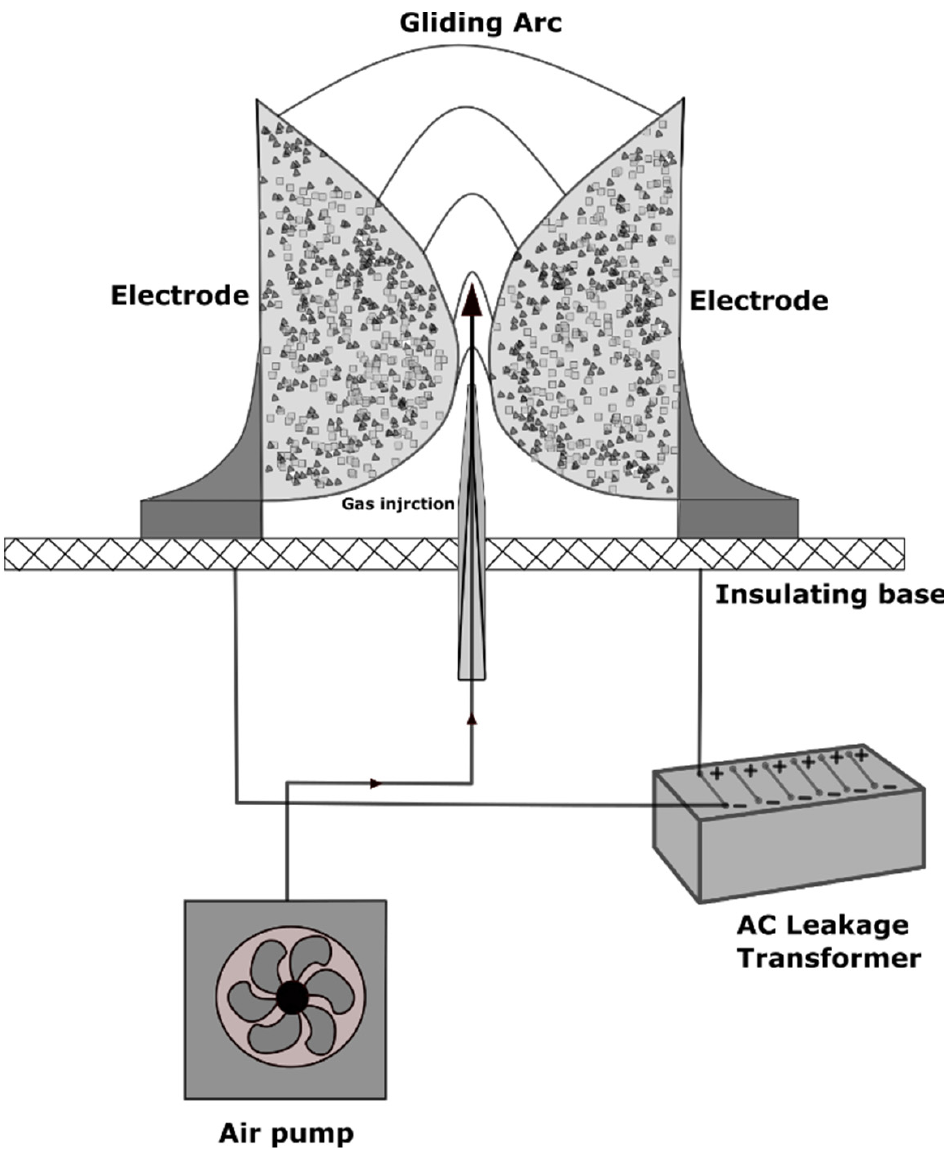
Figure 6. A typical gliding arc setup scheme.